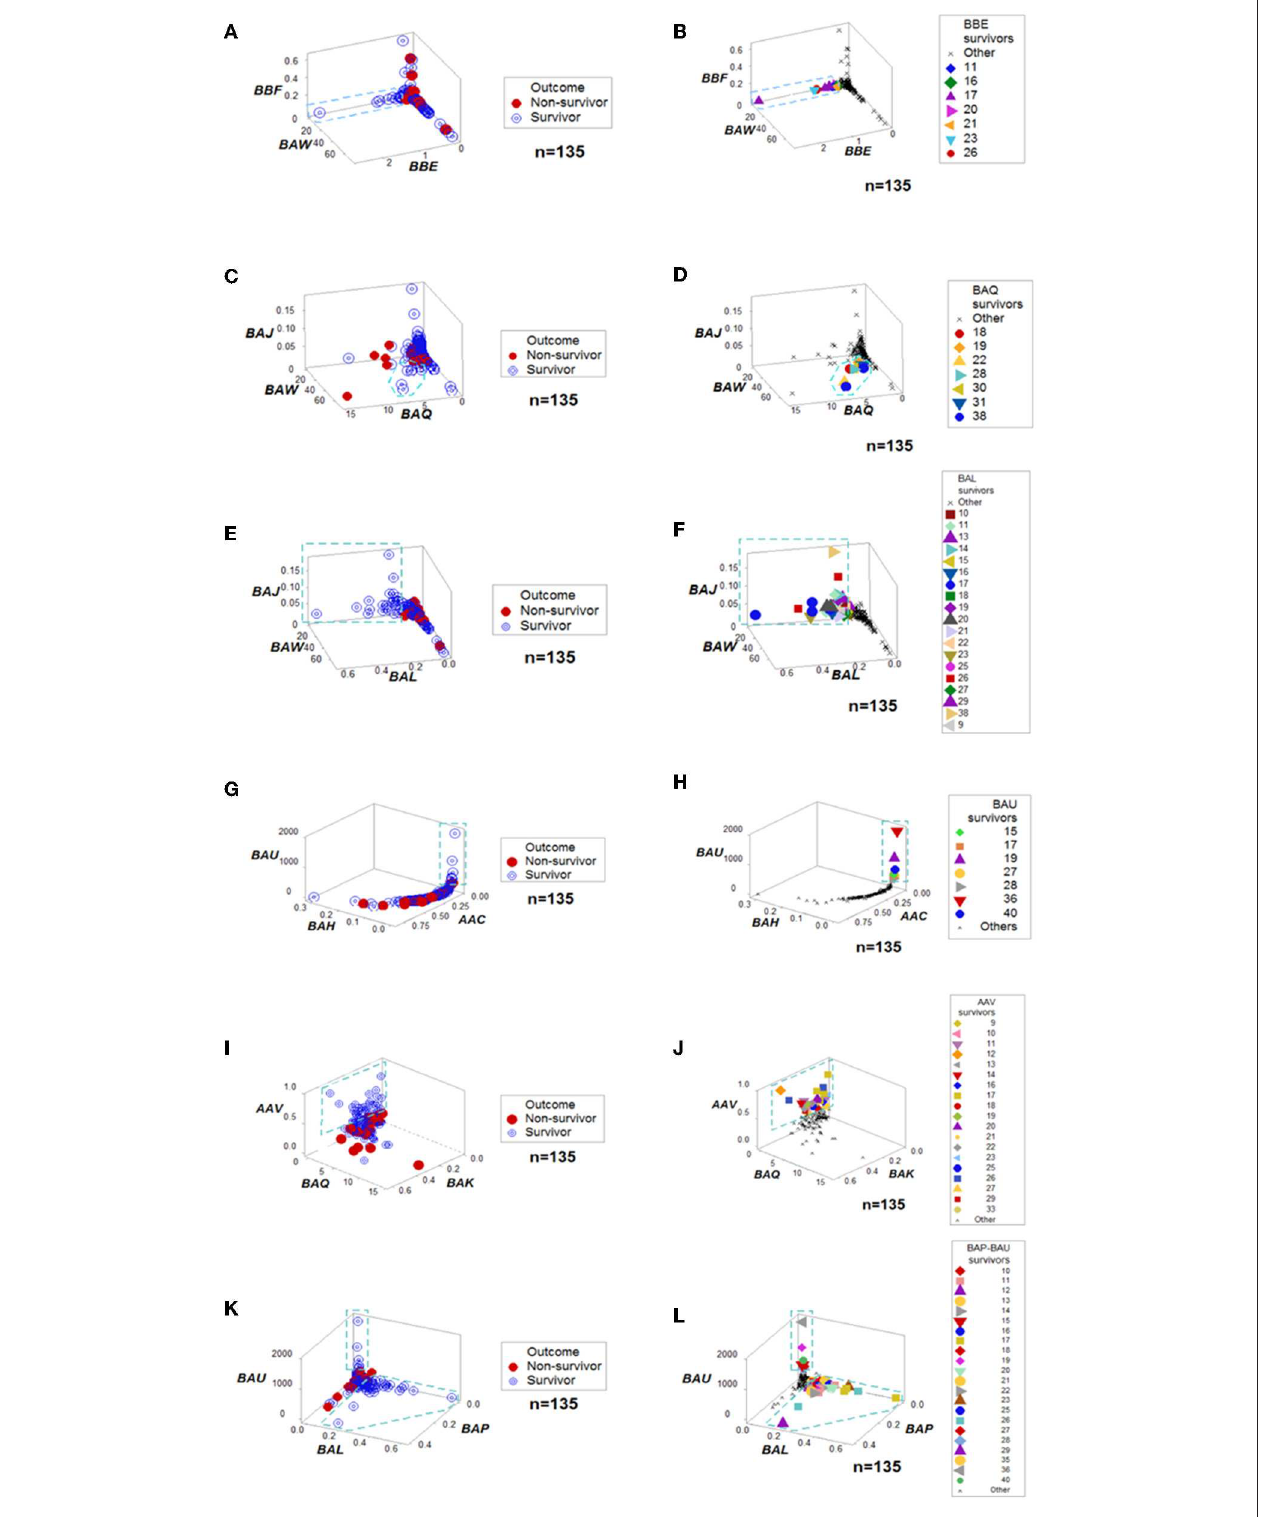
FIGURE 3 | Outcome-specific discrimination. Six data structures revealed distinct patterns among surviving hantavirus-infected humans (A–L) . Redundancy (detection of a similar finding, when a different data structure is considered) was demonstrated. For instance, patient #11 was identified as a “survivor” by four data structures (B,F,J,L) . Numbers refer to patient identifiers. “Other” refers to both other survivors and all non-survivors.